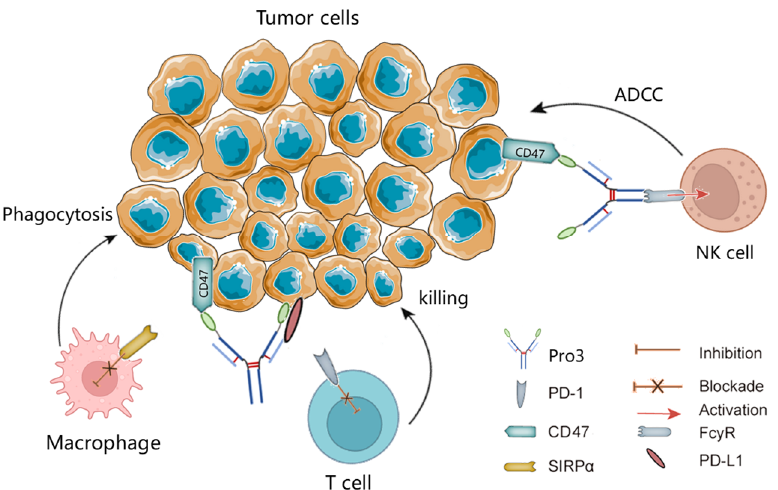
Figure 1. Schematic illustration of blockades of PD-L1 and CD47 by the dual-targeting fusion protein Pro3. ADCC, antibody-dependent cell-mediated cytotoxicity; NK, natural killer; SIRPα, signal-regulatory protein α.